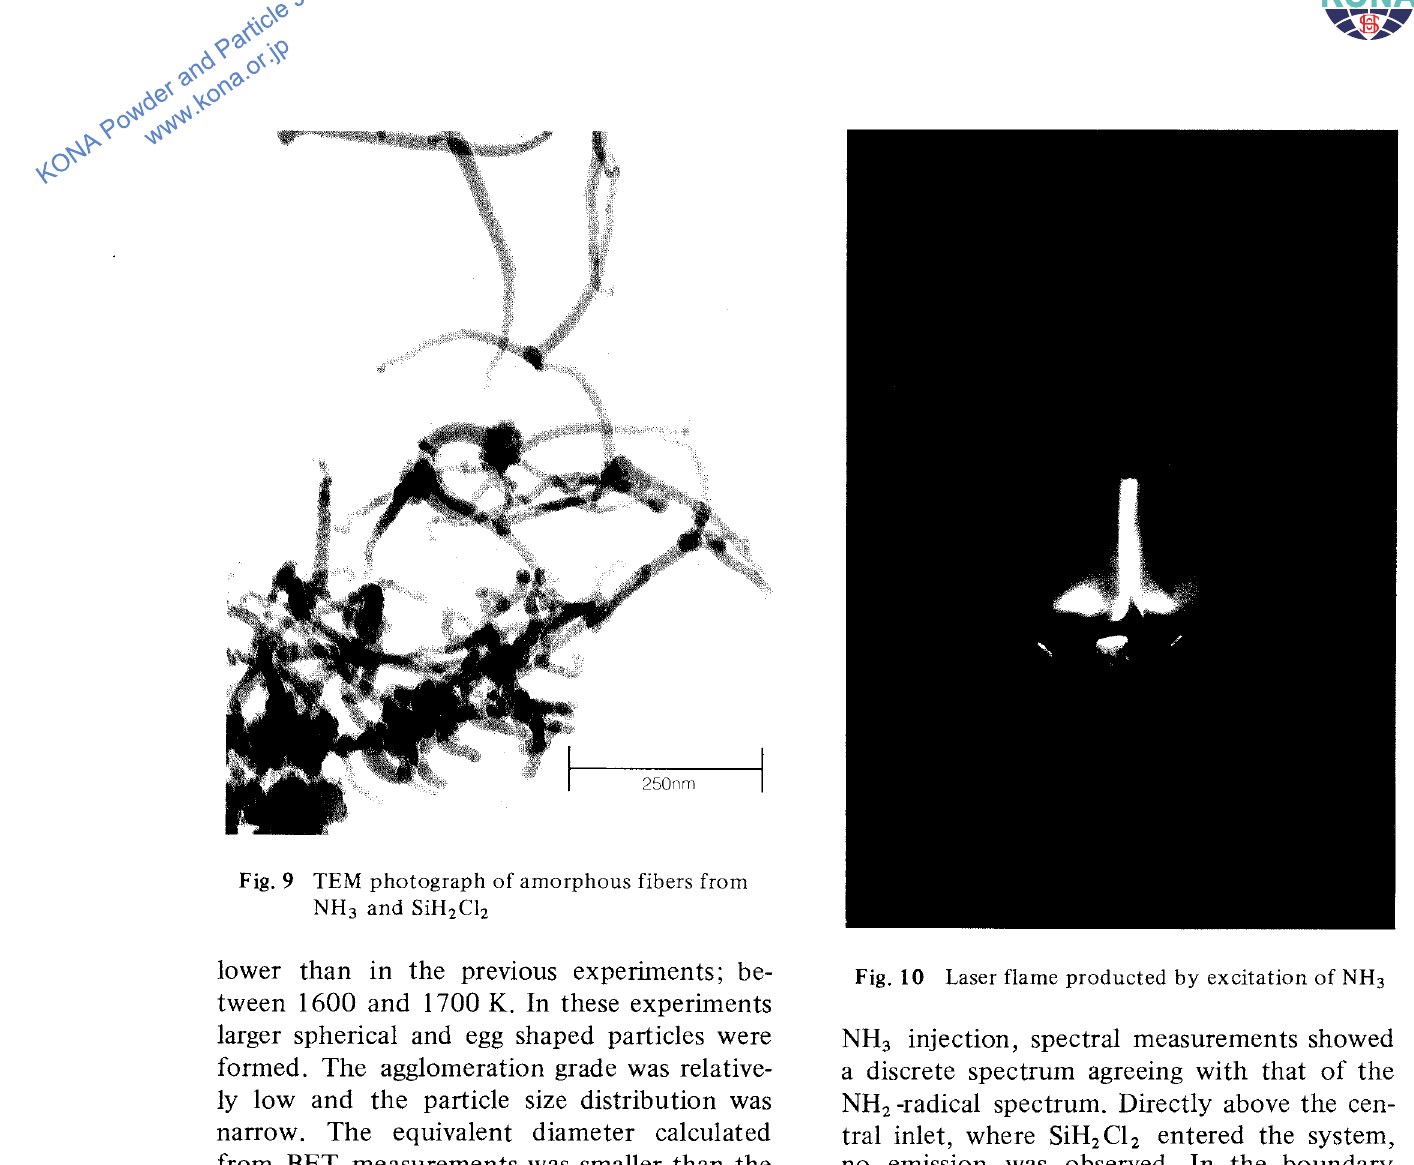
Fig. 10 Laser flame producted by excitation of NH